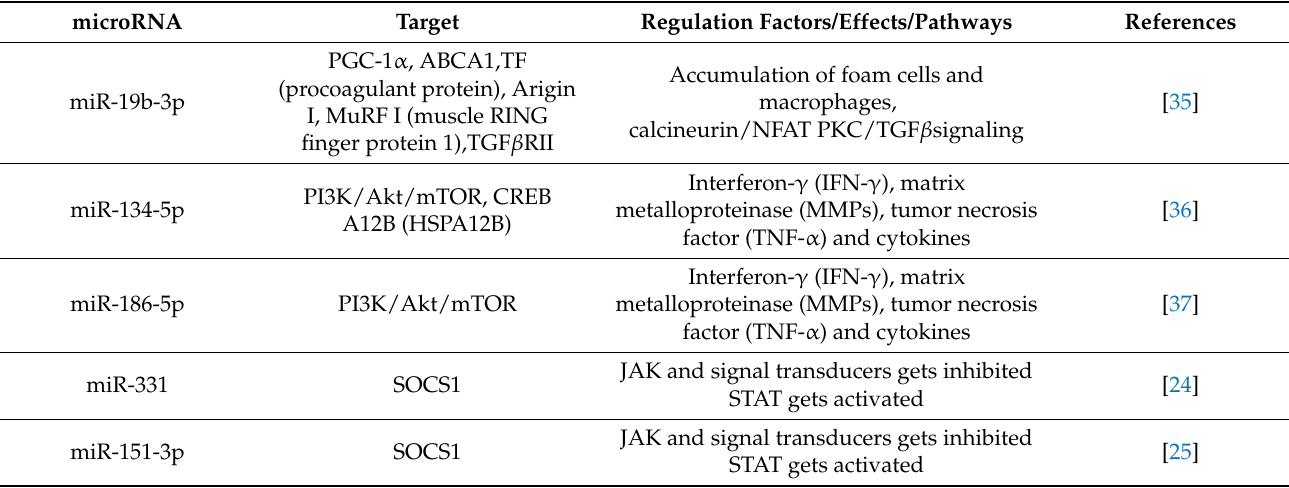
Table 1. List of miR-19b-3p, 134-5p, 186-5p, 331 and 151-3p and their target genes and regulation factors, effects or pathways.